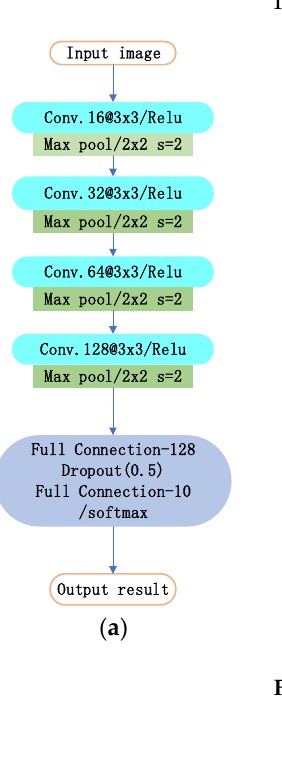
Figure 4 for the IFCNN structure, Figure 8c for the IFCNN1 structure, and Figure 8d for the IFCNN 2 structure.